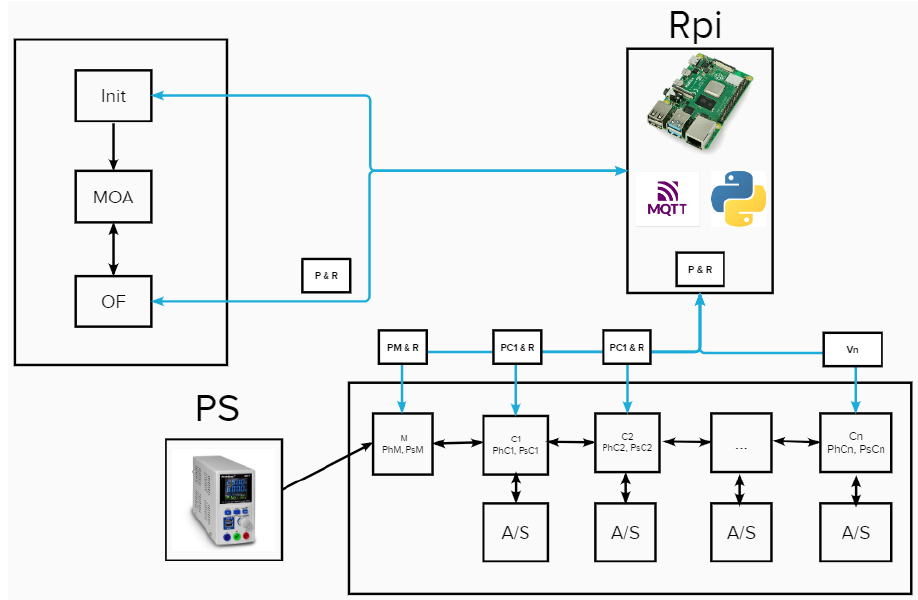
Figure 8. General scheme of the proposed